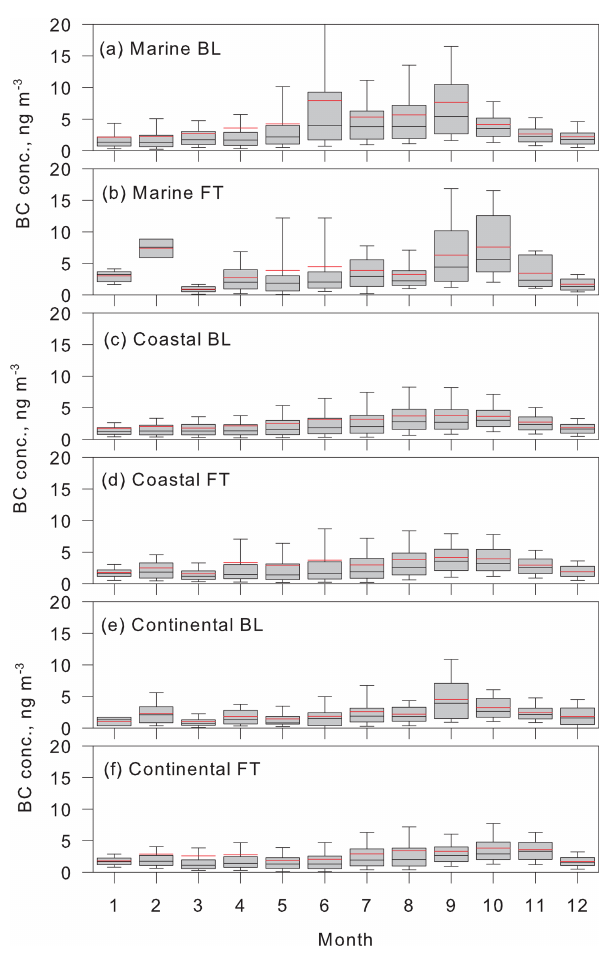
Figure 7. Seasonal features of hourly mean EBC concentrations in each air mass origin at Syowa Station. MBL, MFT, coastal BL, coastal FT, continental BL, and continental FT respectively denote the marine boundary layer, marine free troposphere, coastal bound- ary layer, coastal free troposphere, continental boundary layer, and continental free troposphere. In box plots, the upper bar, upper box line, black middle box line, bottom box line, and bottom bar respec- tively denote values of 90%, 75%, 50% (median), 25%, and 10%. The red line represents mean